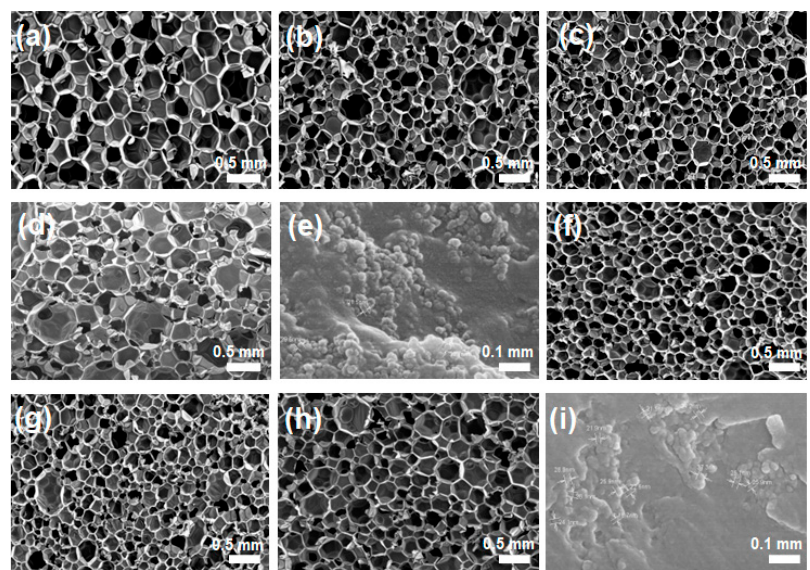
Figure 4. SEM images of neat PU foam without additive ( a ) and PU composite foams with silica nanoparticles without surface modification at different aerogel compositions of ( b ) 1 wt%, ( c ) 3 wt%, and ( d , e ) 5 wt%, and with silica nanoparticles with surface-modified silica nanoparticles of ( f )1 wt%, ( g ) 3 wt%, and ( h , i ) 5 wt%.